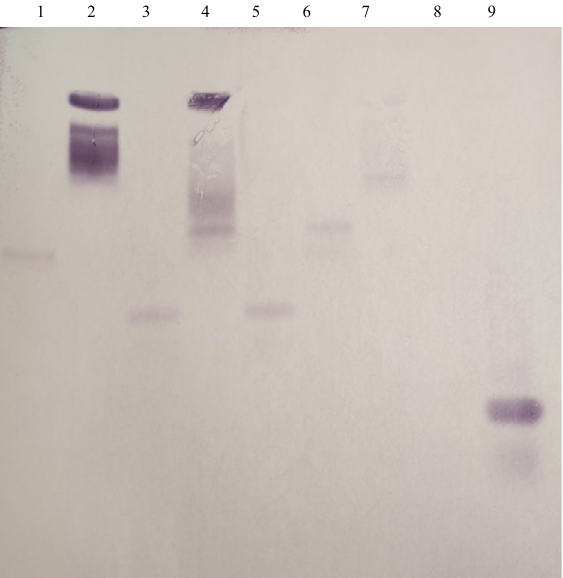
Figure 2. Southern blotting of transgenic birds. Lane 1: shRNA construct, Lanes 2–5: Transgenic birds of 1st generation, Lane6&7: Transgenic birds of 2nd generation; Lane8: Non-transgenic control bird; Lane9: Amplified product from shRNA plasmid construct acted as positive control for Southern blotting. Before running the gel, genomic DNA was digested with Apa I restriction enzyme. The digested sample was run on 0.8% agarose gel and was transferred to PVDF membrane. A 286 bp fragment located at the back bone of pENTR™/U6 vector was amplified from the shRNA construct and was used for preparation of probe. The probe was labelled with biotin- streptavidin conjugated to alkaline phosphatase and detected with NBT/BCIP for spot hybridization.